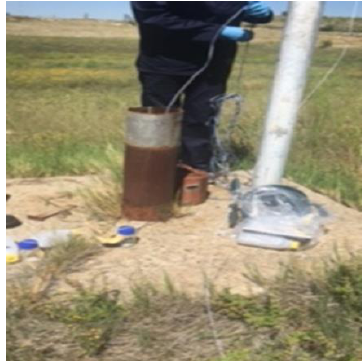
Figure 9. Well-constructed borehole in the northern landfill site.